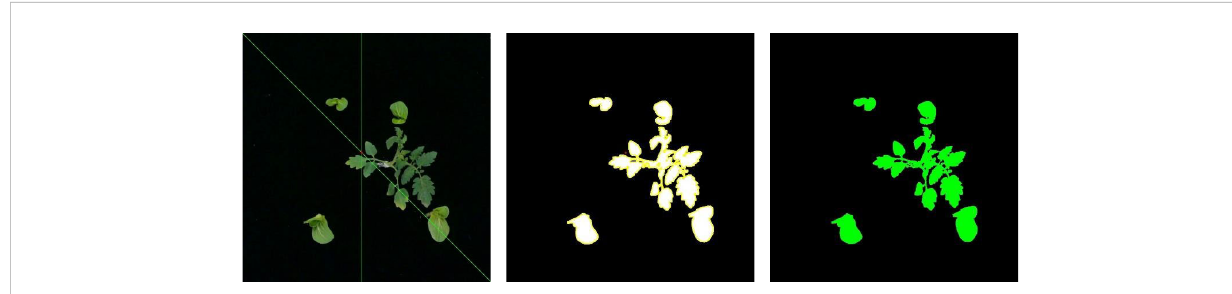
FIGURE 9 Misclassi fi cation due to low camera frame